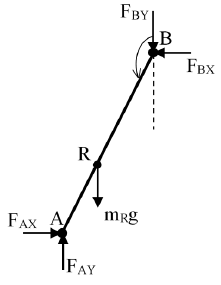
Figure 6. The model of forces on the rod.